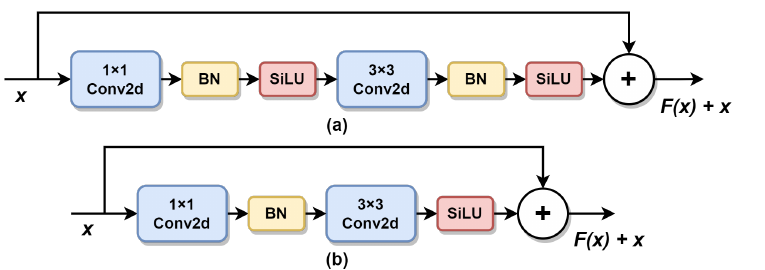
Figure 5. The bottleneck design structure improvement. ( a ) The bottleneck structure of CSP-Darknet. ( b ) The bottleneck structure of the model in this